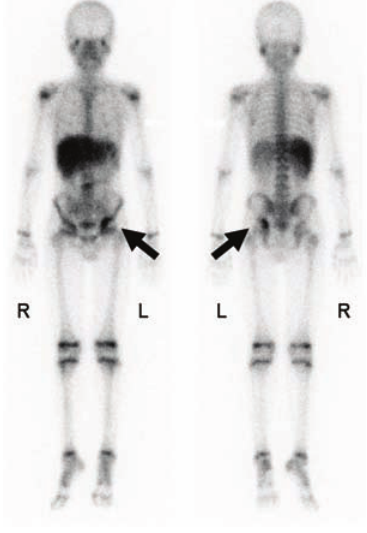
Figure 1. Magnetic resonance imaging (T2) of the pelvis taken on day 8 of hospitaliza- tion. High-intensity signal was detected on the left acetabulum, ilium, and ischium. The top and bottom panels represent the frontal and horizontal views, respectively.